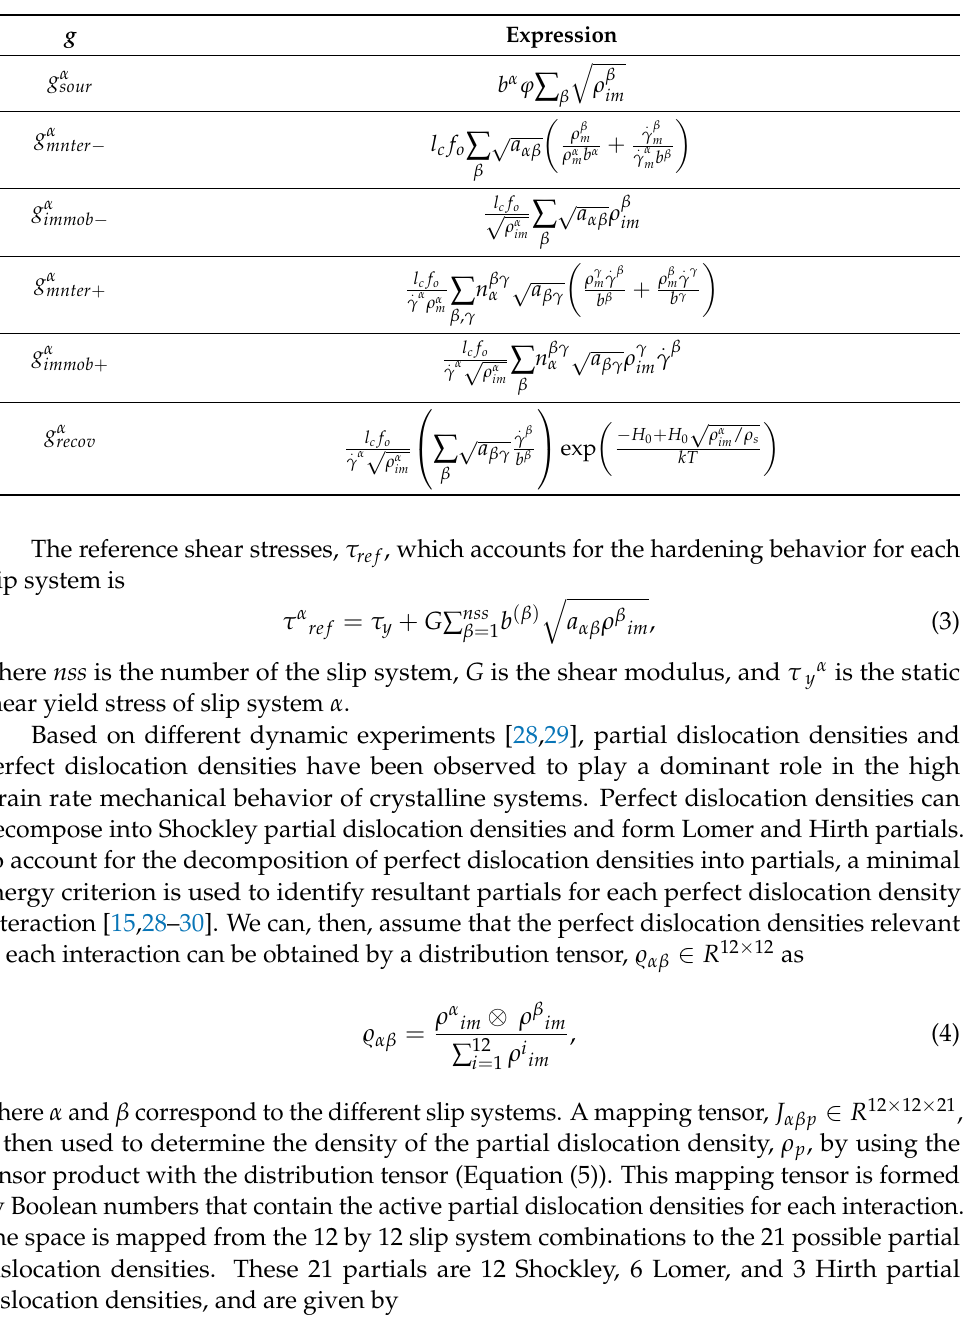
Table 2. Coefficients for the evolution